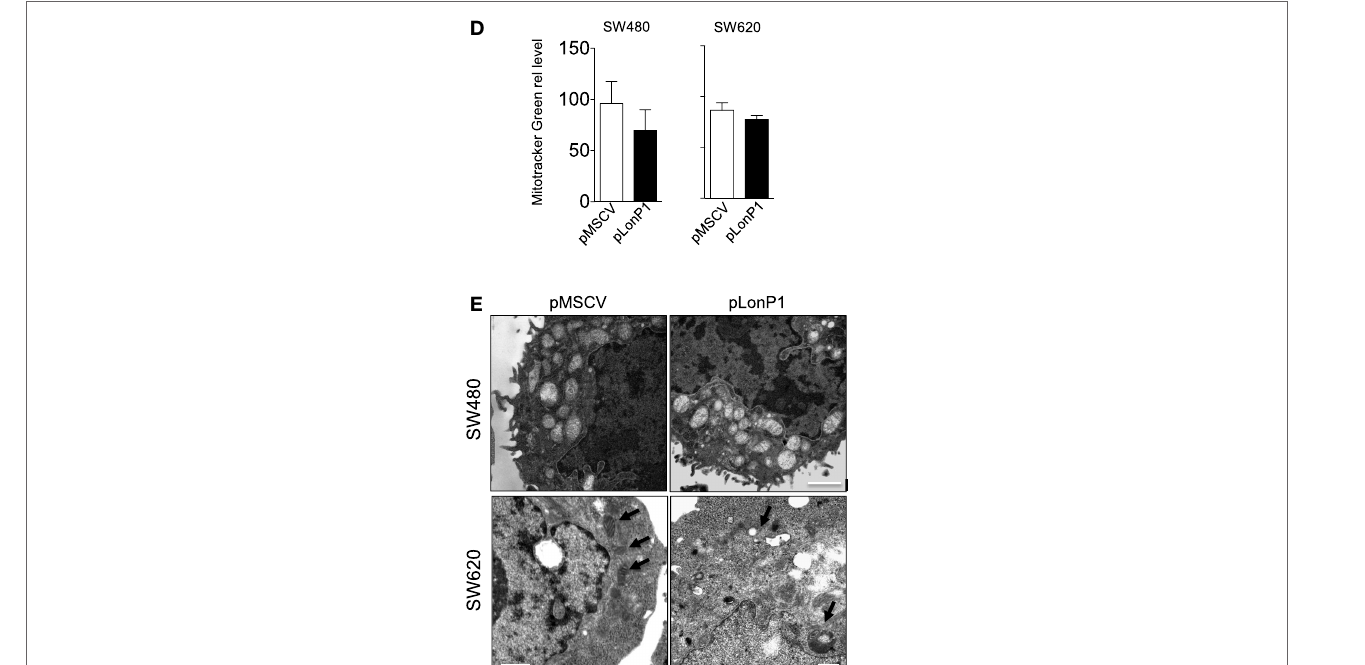
FigUre 7 | LonP1 slightly modulates mitochondrial activity in colon cancer cells. (a) Representative traces and quantitative analysis of the oxygen consumption rate in indicated cells. Subsequent injections of oligomycin (Oligo), mitochondrial decoupler carbonyl cyanide-4-(trifluoromethoxy)phenylhydrazone (FCCP), complex I inhibitor rotenone (Rot), and complex III inhibitor (AntA) were performed as indicated; * P < 0.05. (B) Mitochondrial membrane potential quantification was assayed by tetramethyl rodhamine methyl esther (TMRM) in the presence or absence of CCCP in indicated cells. Data are expressed as percentage of increase in median fluorescence intensity (MFI) and represented the mean ± SD ( n = 4); * P < 0.05. (c) Mitochondrial anion superoxide quantification as assayed by MitoSOX Red Mitochondrial Superoxide Indicator (mitoSOX) in the presence or absence of hydrogen peroxide in indicated cells. Data are expressed as percentage of increase in MFI and represented the mean ± SD ( n = 4). (D) Mitochondrial mass quantification as assayed by Mitotracker Green in indicated cells. Data are expressed as percentage of increase in MFI and represented the mean ± SD ( n = 4); * P < 0.05. (e) Representative transmission electron microscopy images of indicated cells. Scale bars, 1 µm.